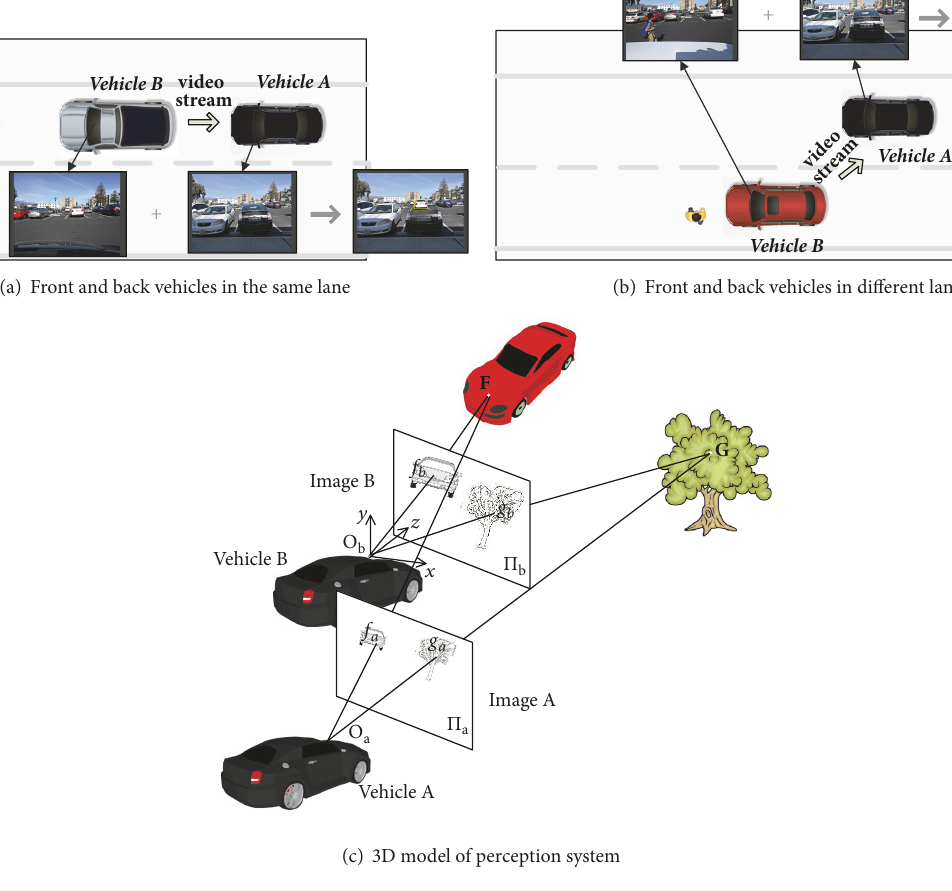
Figure 1: Street super perception